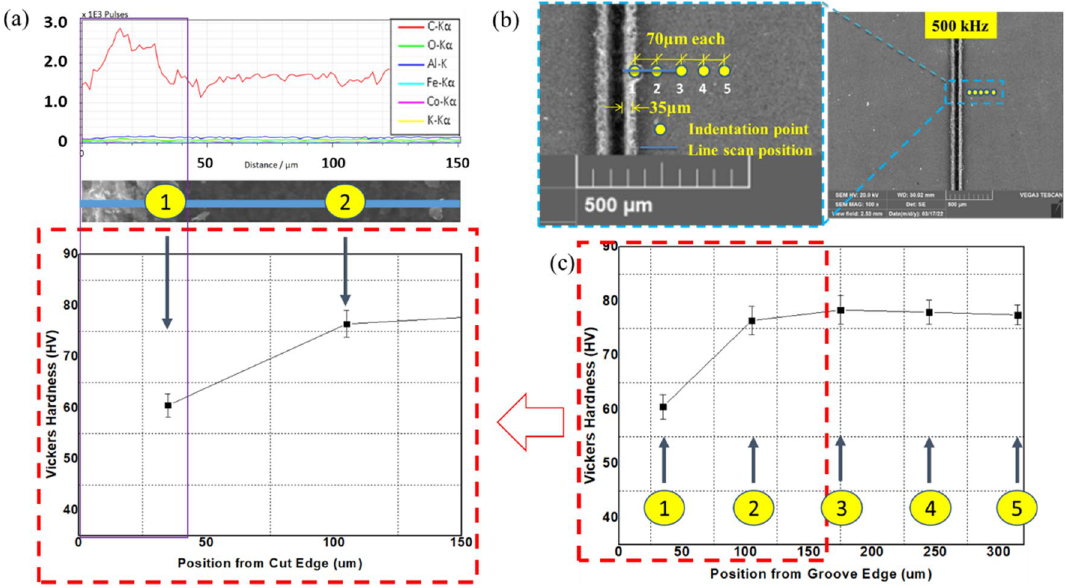
Figure 20. Chemical and hardness tests on surface—500 kHz; ( a ) EDX line scan ( b ) measurement configuration ( c ) Vickers